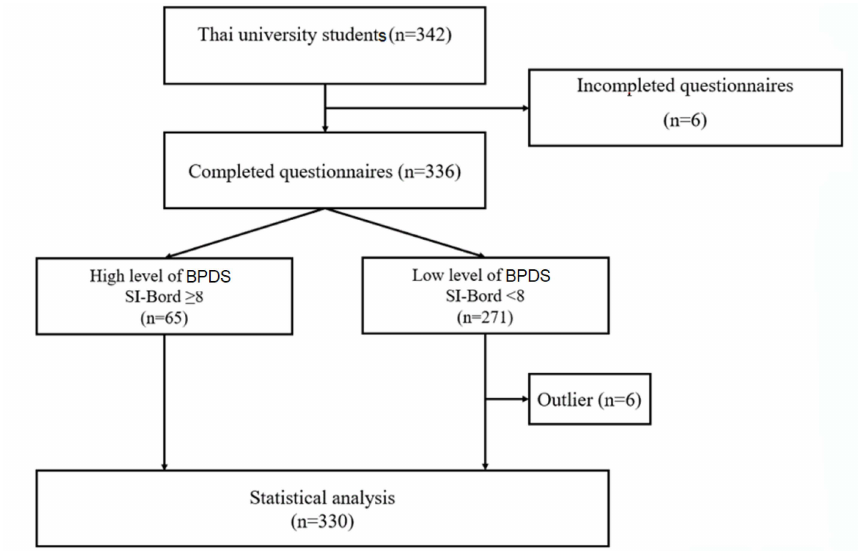
Figure 1. Flow chart for the study sample size. BPDS = borderline personality disorder symptoms. SI-Bord = screening instrument for borderline personality